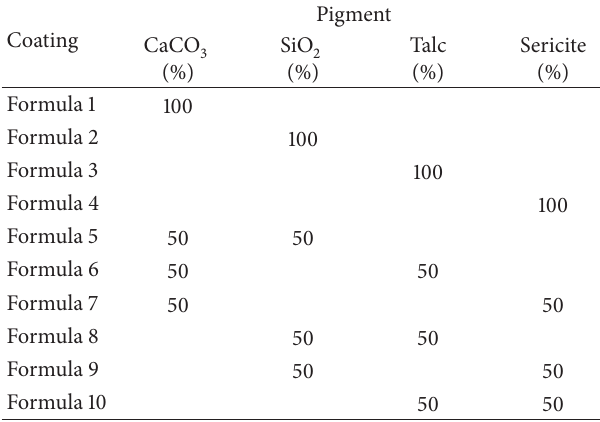
Table 2: Ten coating formulations of dye sublimation transfer pa-